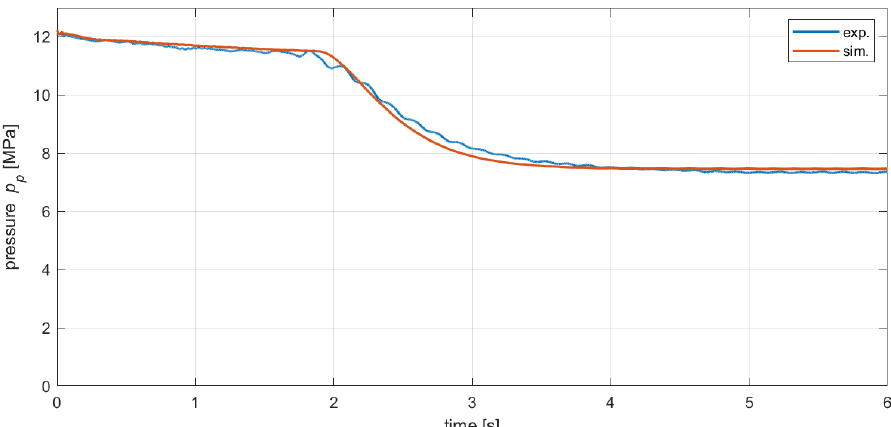
Figure 15. Measurement and result of simulation of the waveform of rotational speed on the motor, n s , for the control signal rise time t 0 = 1 s.